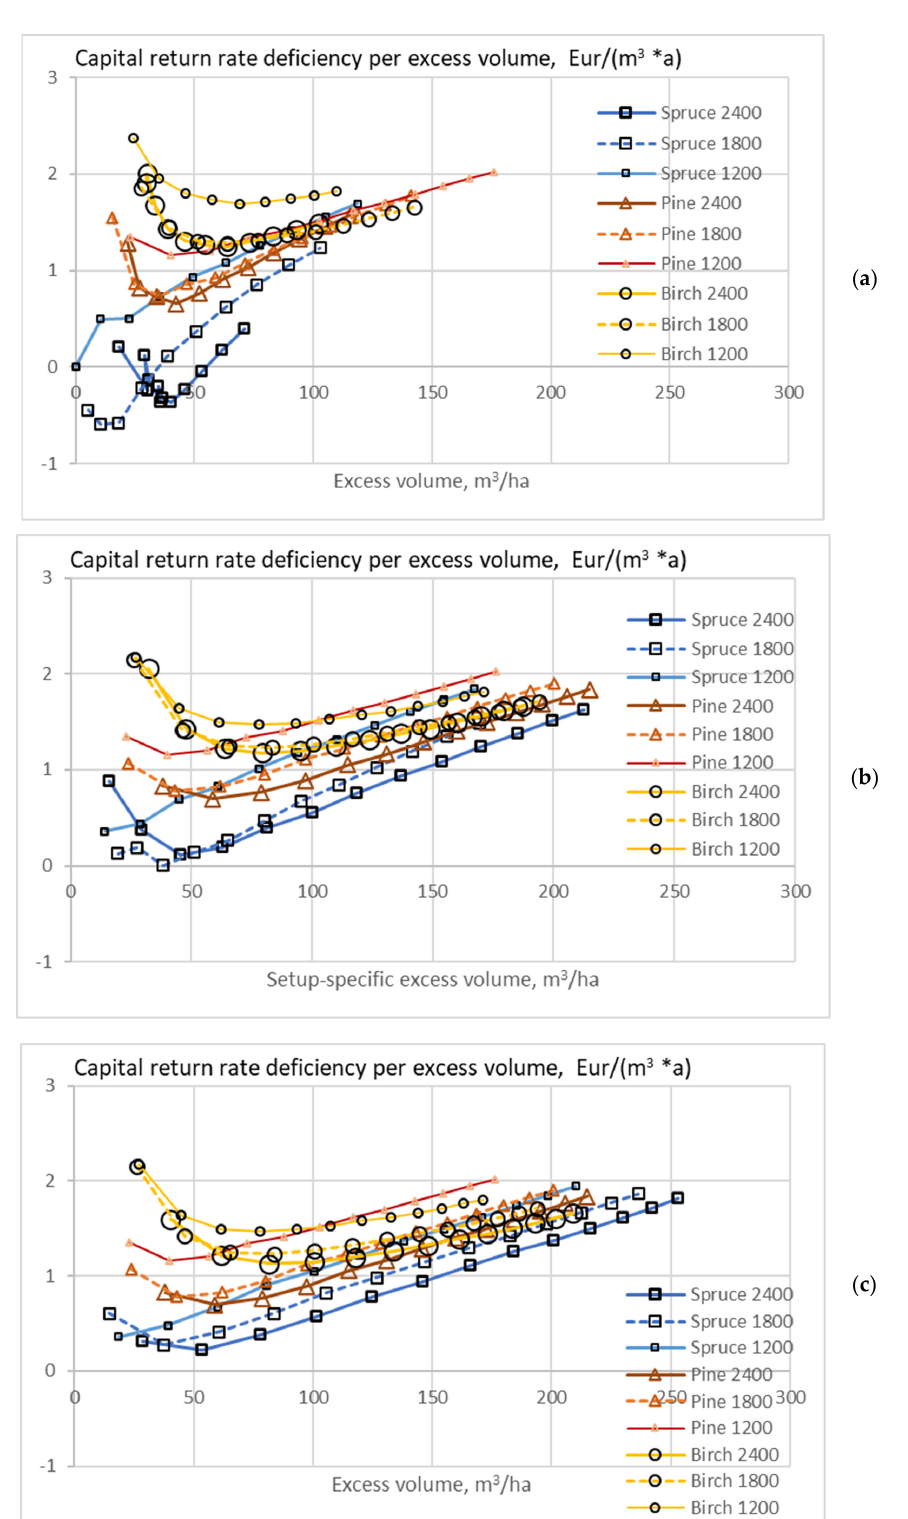
Figure 16. The expected value of capital return rate deficiency per excess volume unit on stands of different initial sapling densities, with proportional goodwill, as a function of excess volume, when the growth model is applied as early as applicable, without any thinning restriction ( a ), in good-quality trees of at least 238 mm of diameter only removed in thinning ( b ), and without any commer- cial thinning ( c ). The expected value of capital return rate and stand volume from spruce stands with 1200 saplings per hectare is taken as the common reference.